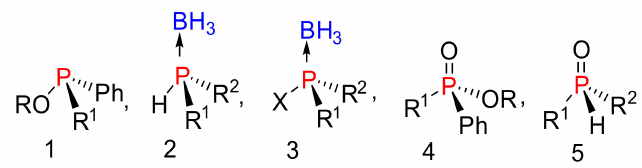
Figure 1. Structure of asymmetric phosphate